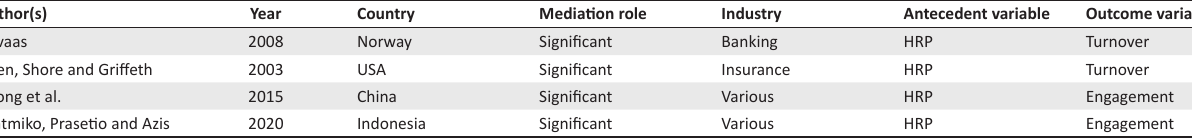
TABLE 4: Mediation of perceived organisation support on turnover intention.